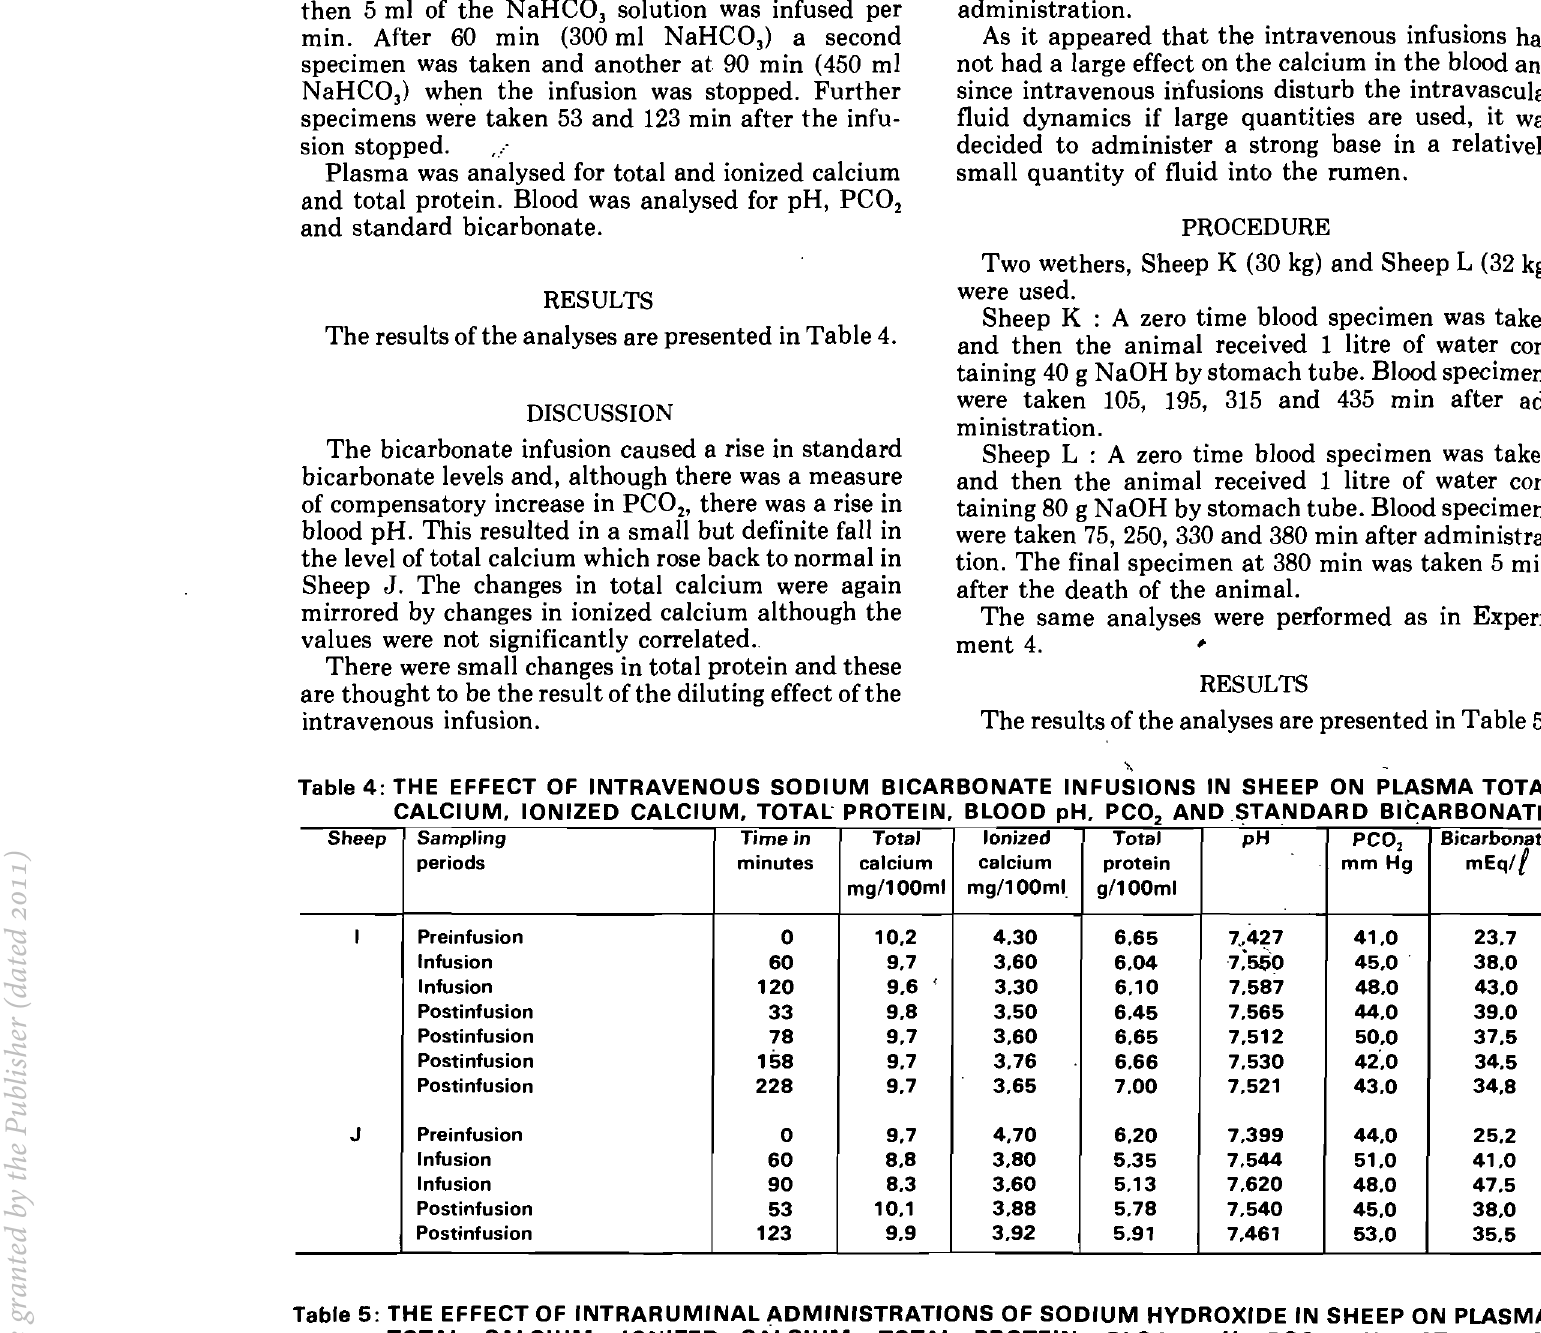
Table 5: THE EFFECT OF INTRARUMINAL ADMINISTRATIONS OF SODIUM HYDROXIDE IN SHEEP ON PLASMA